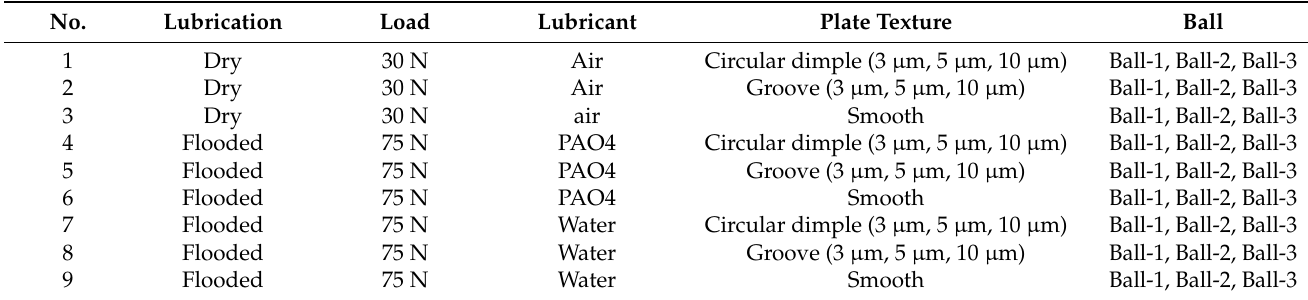
Figure 3. Schematic diagram of lubrication conditions. Table 4. Test programs.